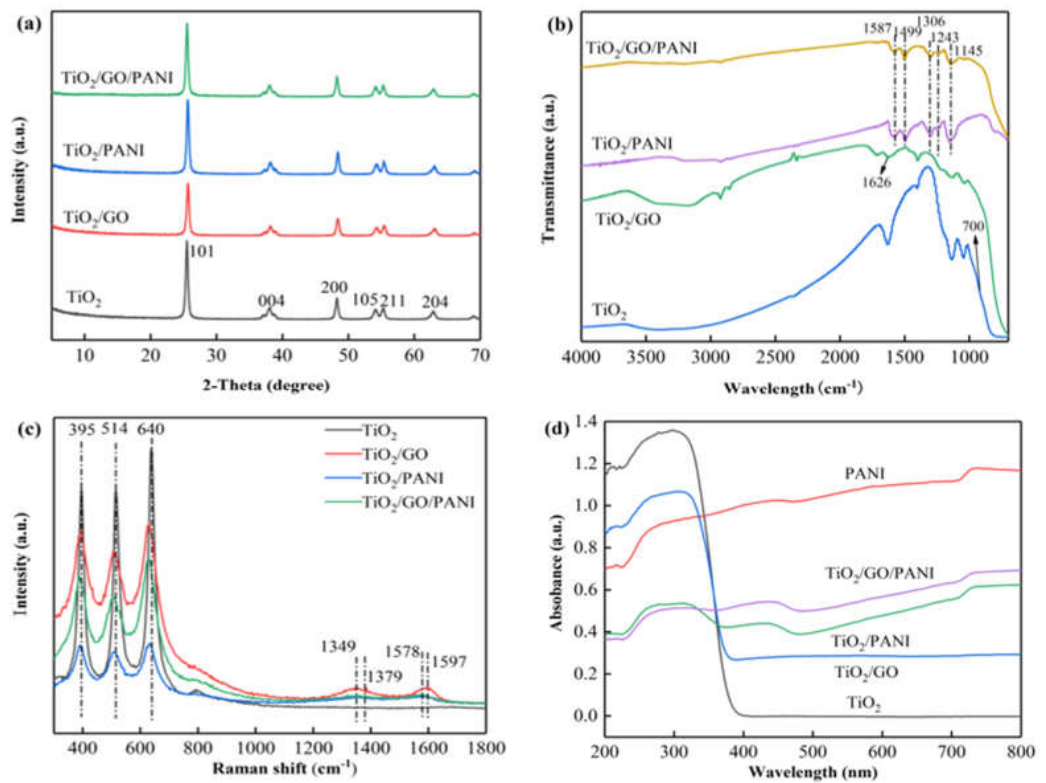
Figure 3. ( a ) XRD patterns, ( b ) FTIR spectra, ( c ) Raman spectra, ( d ) UV–vis DRS.